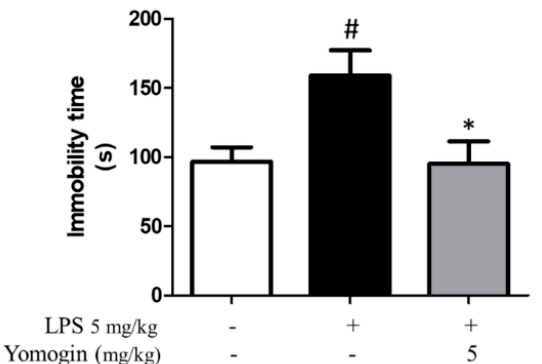
Figure 8. Effects of yomogin on behavioral dysfunction in LPS-treated mouse. Mice were orally pretreated with yomogin at 5 mg/kg once daily for 3 days. LPS was injected 1 h after administering yomogin, and mice were sacrificed 3 h later. For FST analysis, immobility time in water was measured during 4 min ( n = 5 per group). Data were analyzed by one-way ANOVA, followed by Tukey’s post hoc test. # p < 0.05 compared to the control group; * p < 0.05 compared to the LPS-injected group. Values are the mean ± SEM.